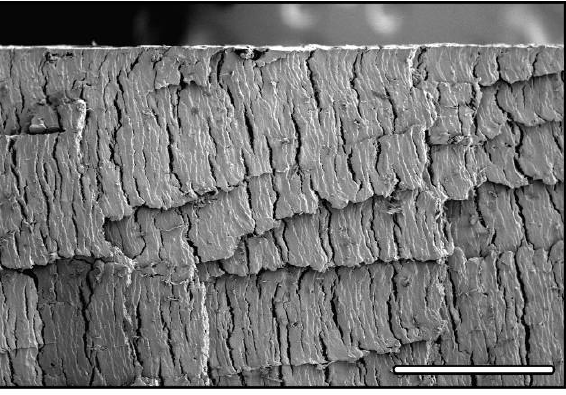
Figure 8. Diffusion defects in freeze-cast alumina. Cross-section parallel to the solidification direction. The displacement of the solidification interface occurred from left to right. Scale bar 700 μ